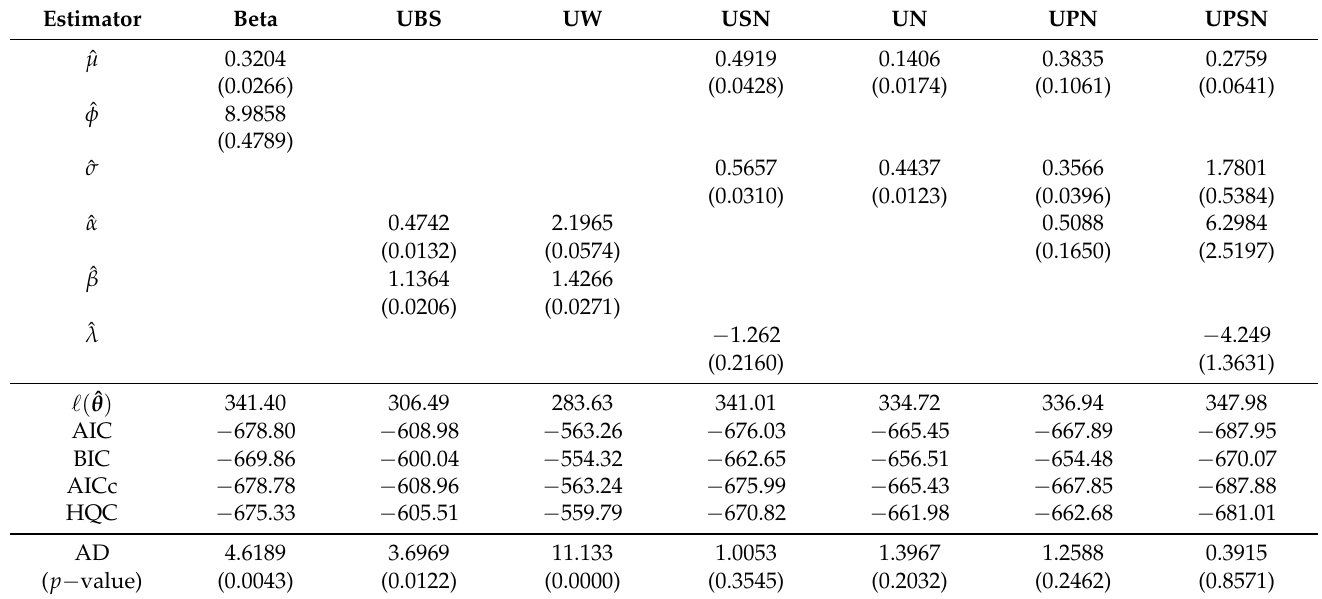
Table 5. Estimation of the parameters, with their standard errors, of the beta, UBS, UW, USN, UN, UPN and UPSN